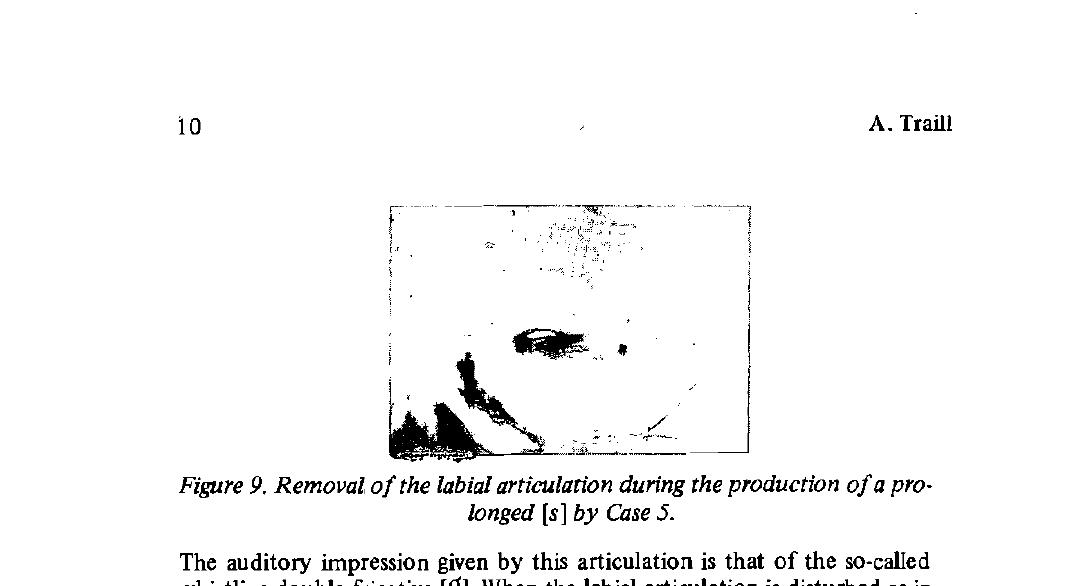
Figure 9. Removal of the labial articulation during the production of a pro- longed [s] by Case